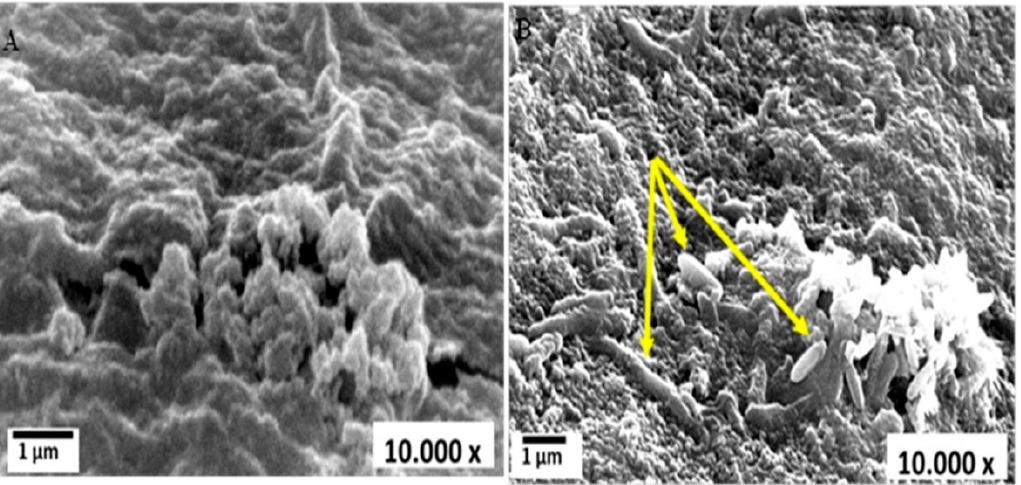
Figure 1. Scanning electron microscope (SEM) micrograph of blank alginate microsphere before and after bacterial cell immobilization: ( A ) blank alginate microsphere; ( B ) immobilized bacterial consortium in alginate microsphere.